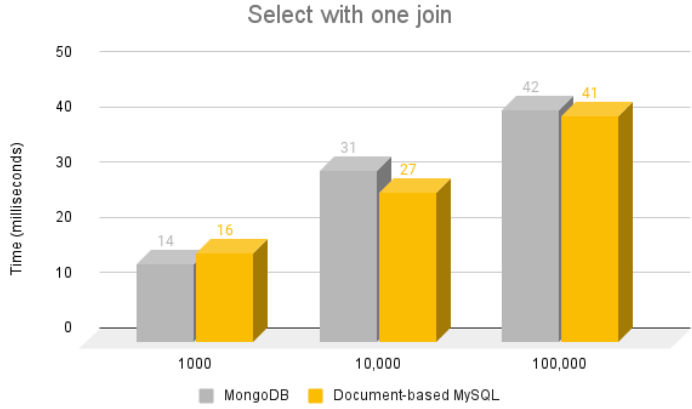
Figure 6. Execution times for select using a single join operation.